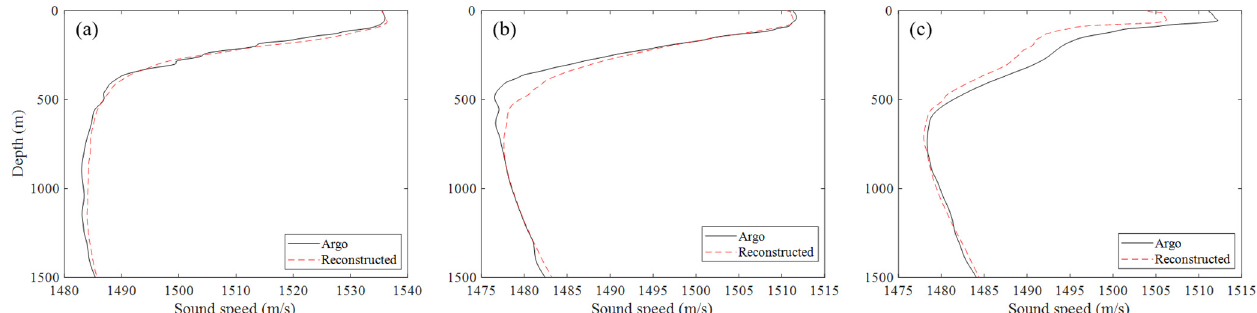
Figure 8. The Argo SSP and the reconstructed SSP in ( a ) Area A, ( b ) Area B, and ( c ) Area C, marked with black and red dashed lines, respectively. with black and red dashed lines,